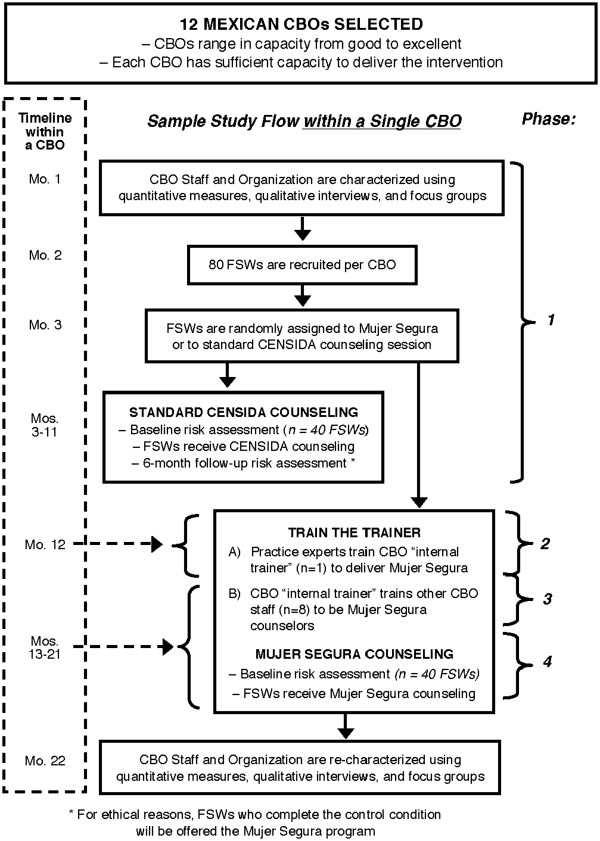
Study flow at participating implementation sites.